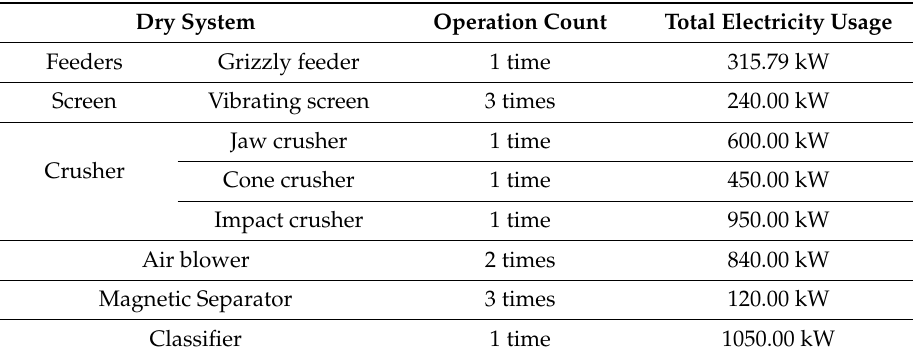
Table 3. Manufacturing facility for wet recycled aggregate.